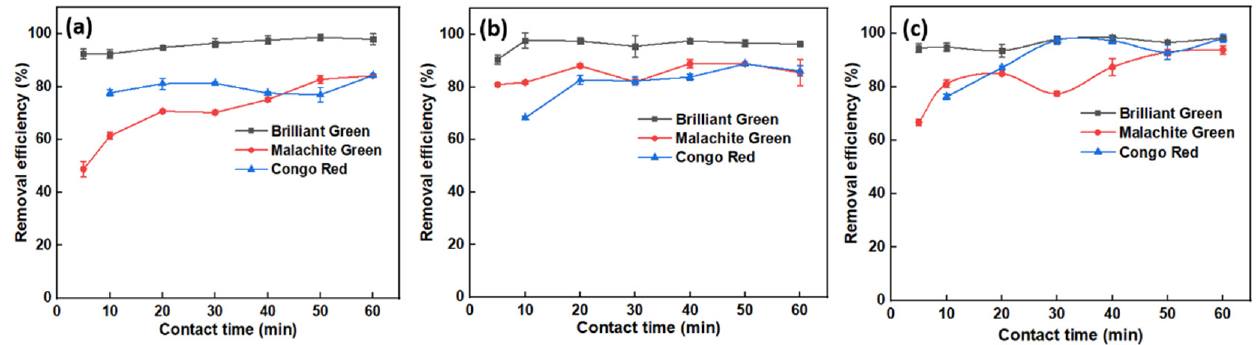
Figure 5. Impact of adsorbent dosage on the removal of BG, MG and CR dyes: ( a ) 0.5 mg, ( b ) 1 mg, ( c ) 1.5 mg.